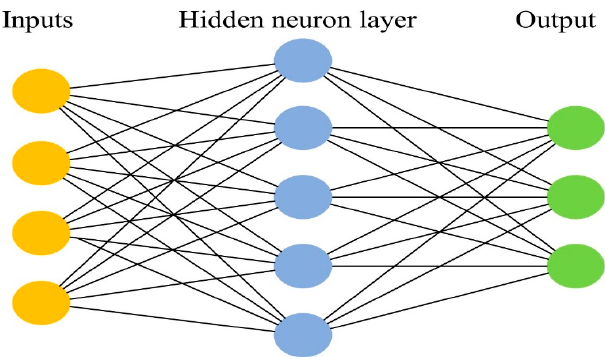
Figure 12. Basic structure of a neural network.